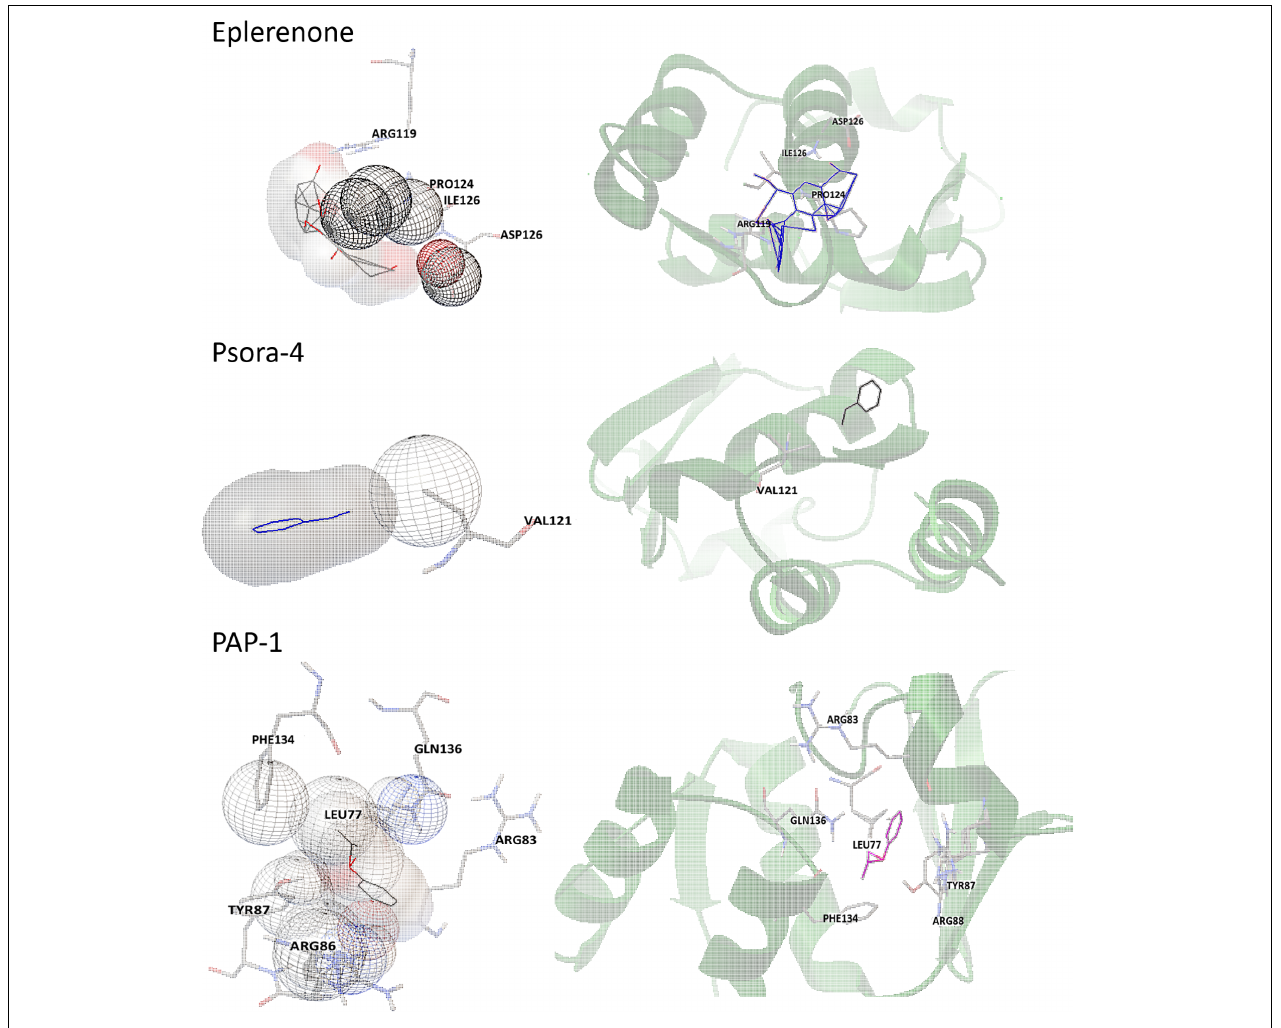
FIGURE 8 | Stereo view of important residues in Kv1.3. Protein is shown in transparent cartoon, ligands and important residues in sticks.